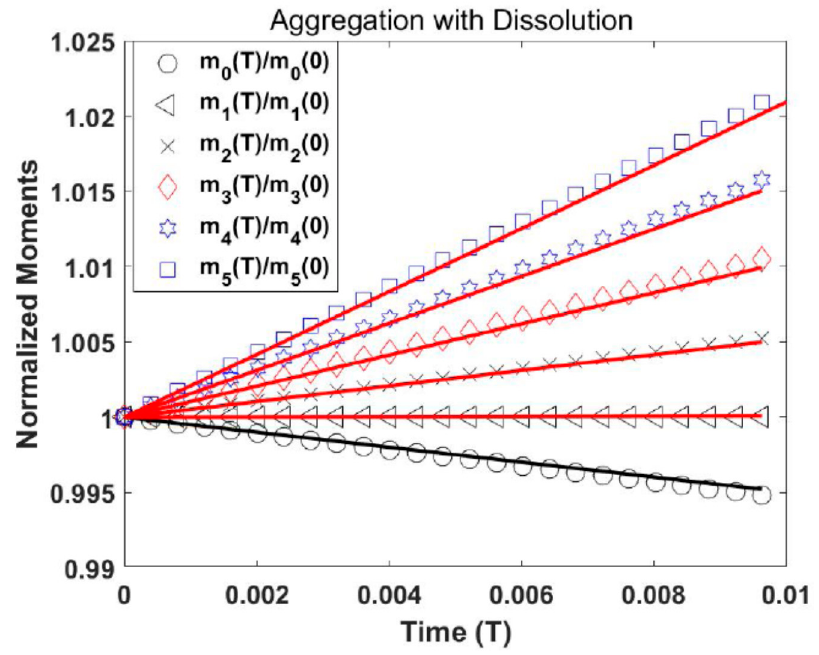
Figure 2. Aggregation with fines dissolution.